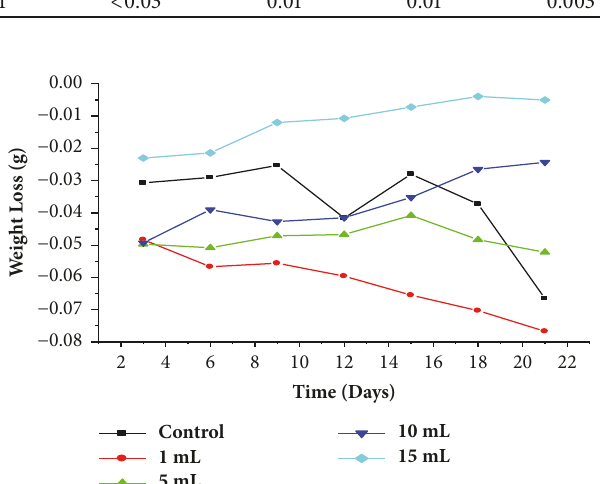
Figure 1: Variation of weight loss against time for the cathodic protection and oil extract for steel with zinc in different volumes of oil extracts in